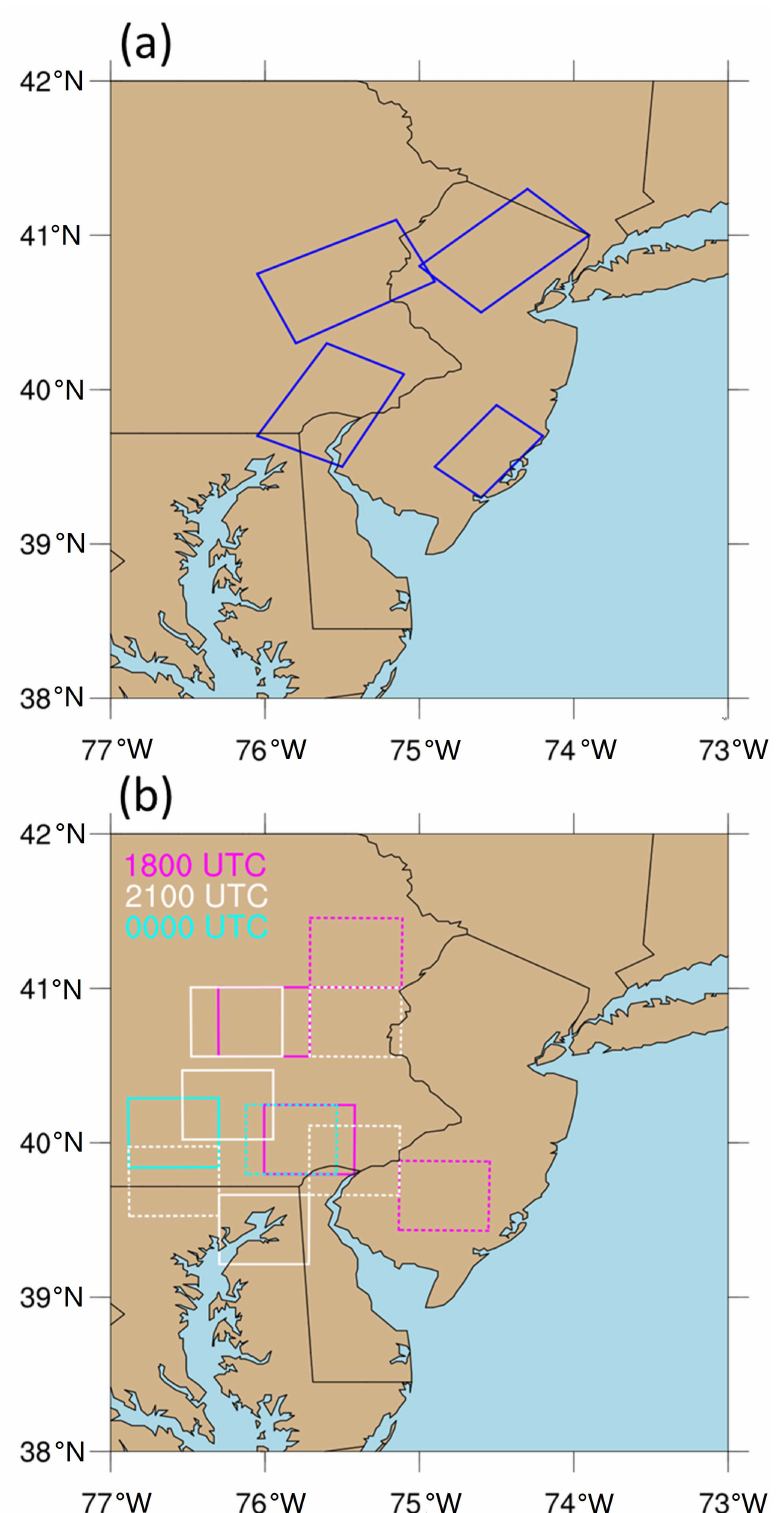
Figure 8. Regions used for roll wavelength measurements shown in Figure 7 and for WRF surface wind speed probability density function (PDF) analysis discussed in Section 5. ( a ) Regions used for radar-observed wavelength analysis. ( b ) Regions used for WRF roll wavelength and wind speed PDF analysis, where solid (dashed) lines denote 50 × 50 km regions exhibiting the presence (absence) of rolls. Line colors identify the WRF time